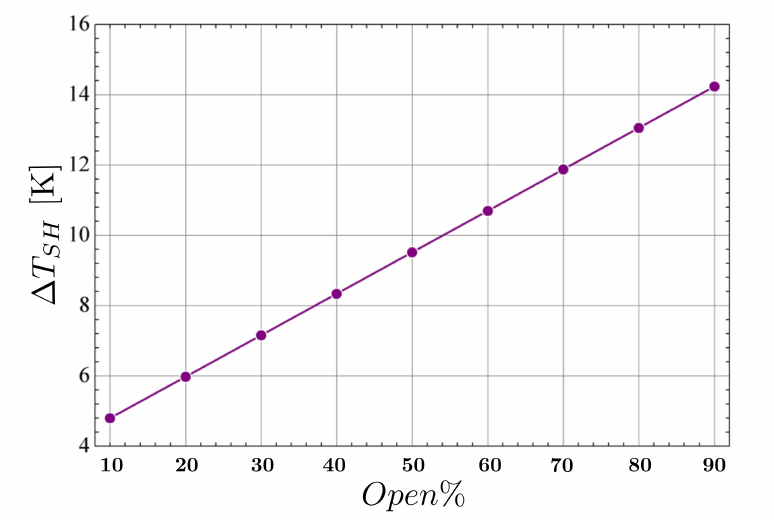
Figure A8. Amount of superheating in evaporator vs EV orifice